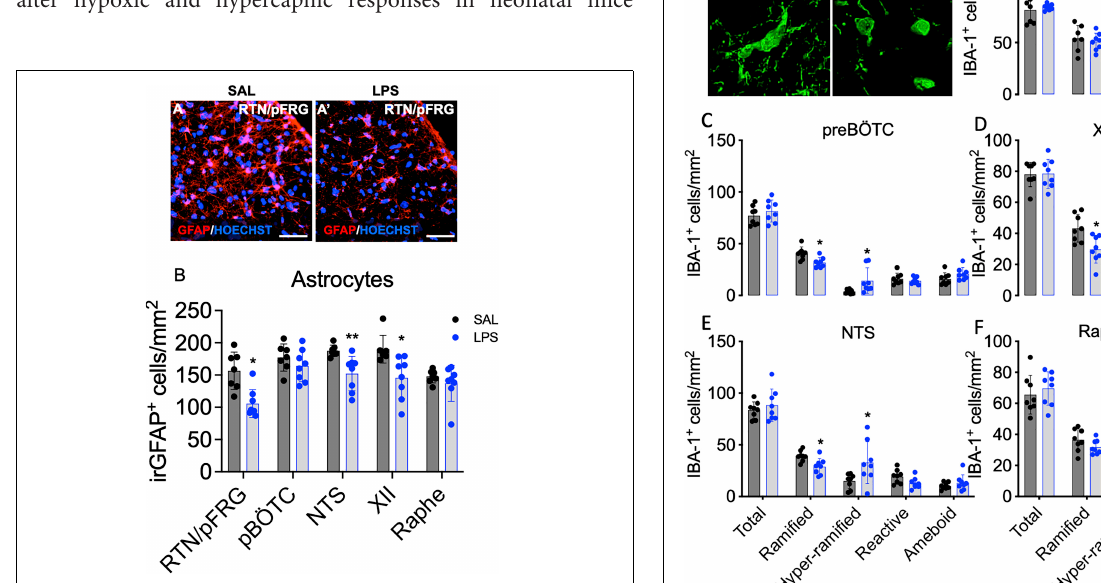
Frontiers in Physiology |